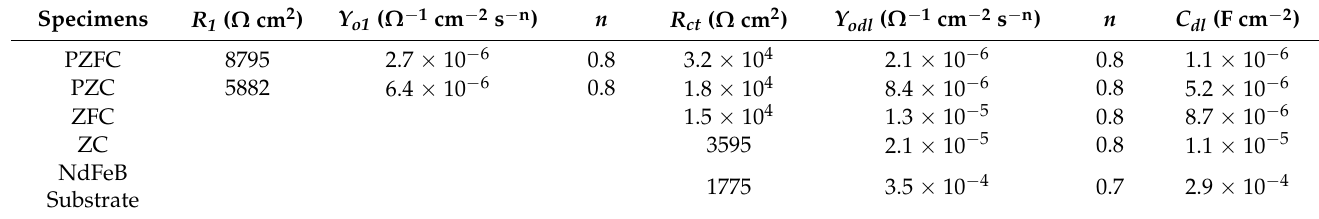
Table 4. Electrochemical parameters fitted by equivalent